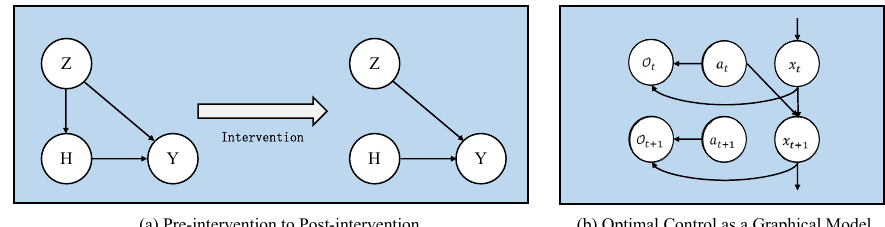
Figure 1. Back-door criterion and graphical model of optimal